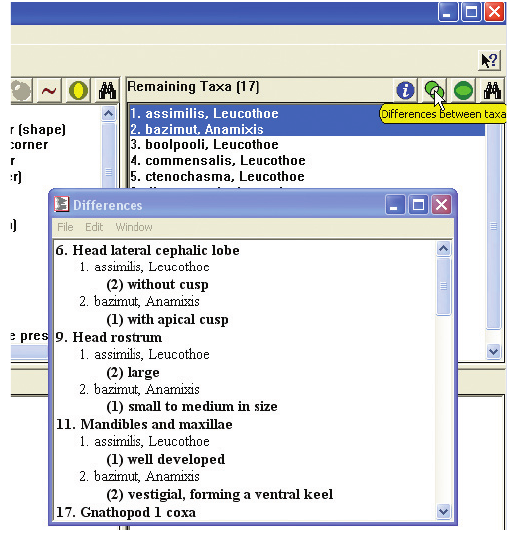
Figure 59. Diff erences between taxa